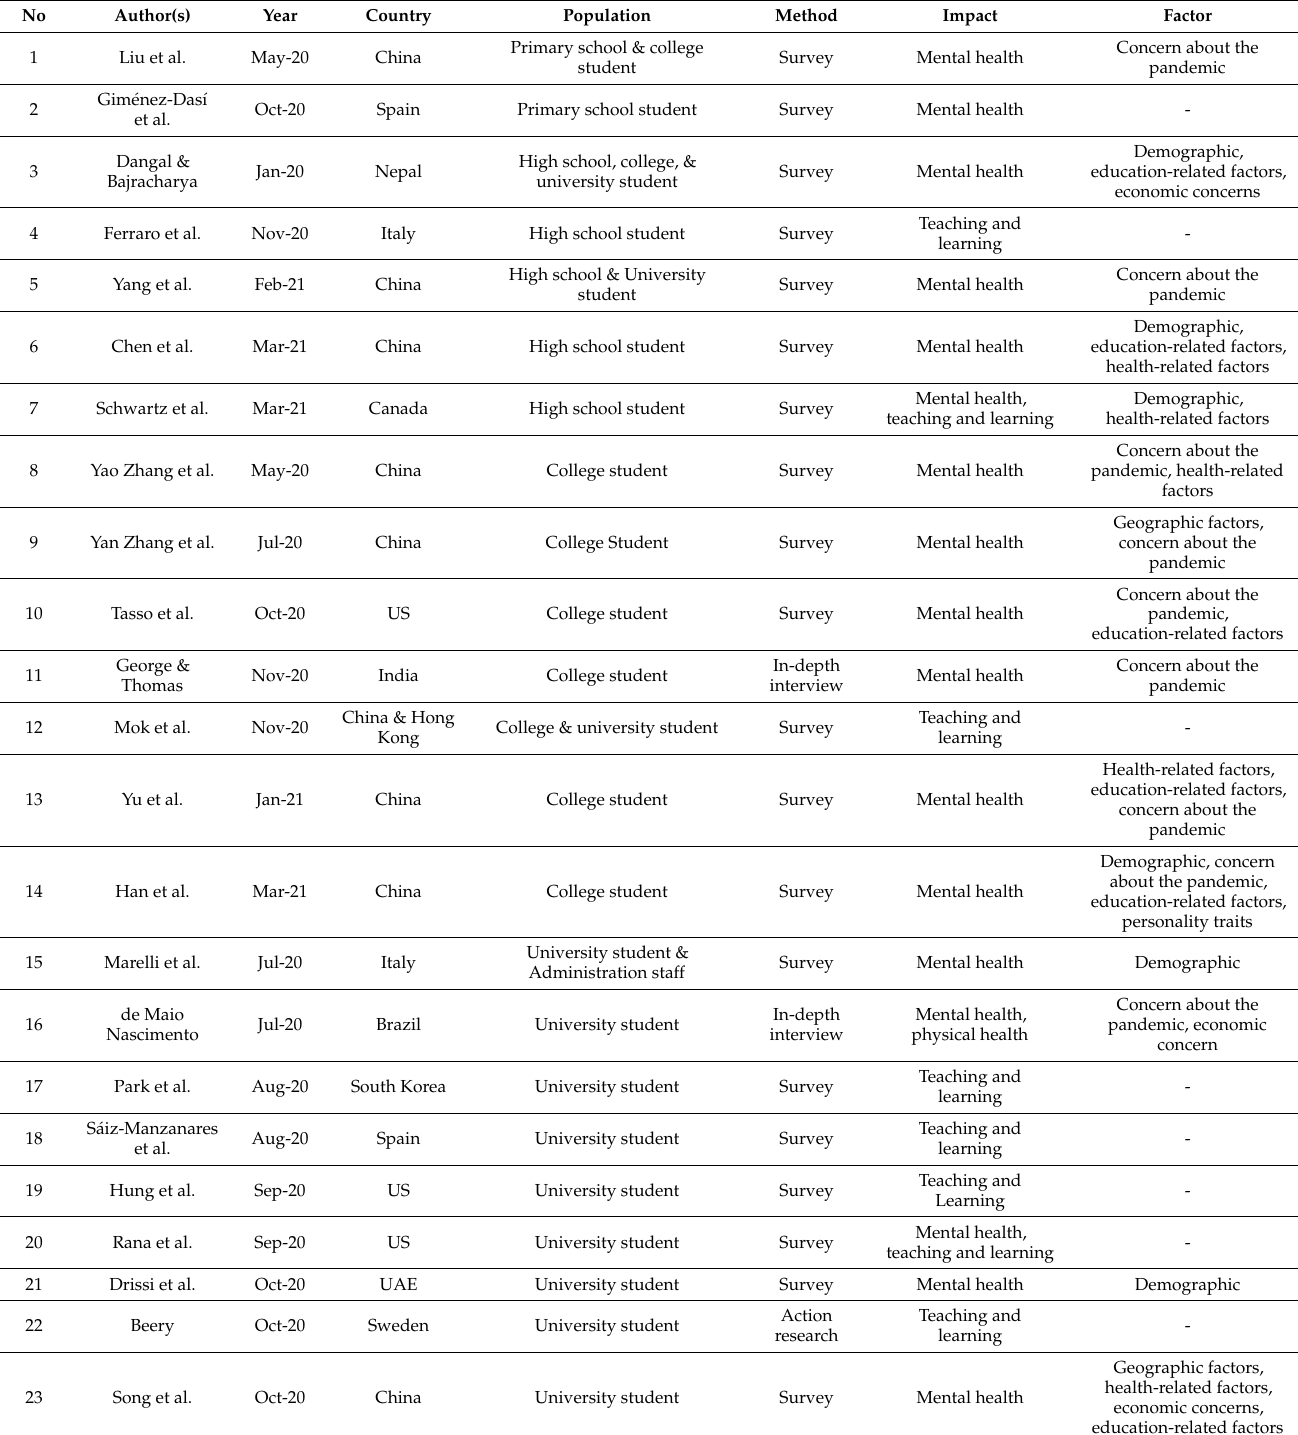
Table 3. Characteristics of the included